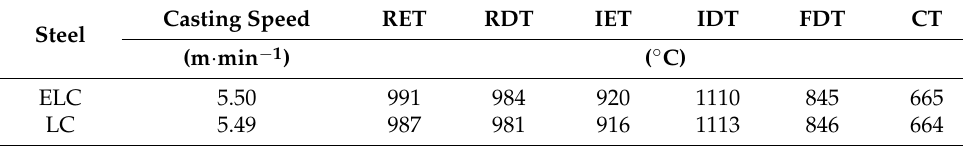
Table 2. Process parameters of the ESP line for 1.0 mm